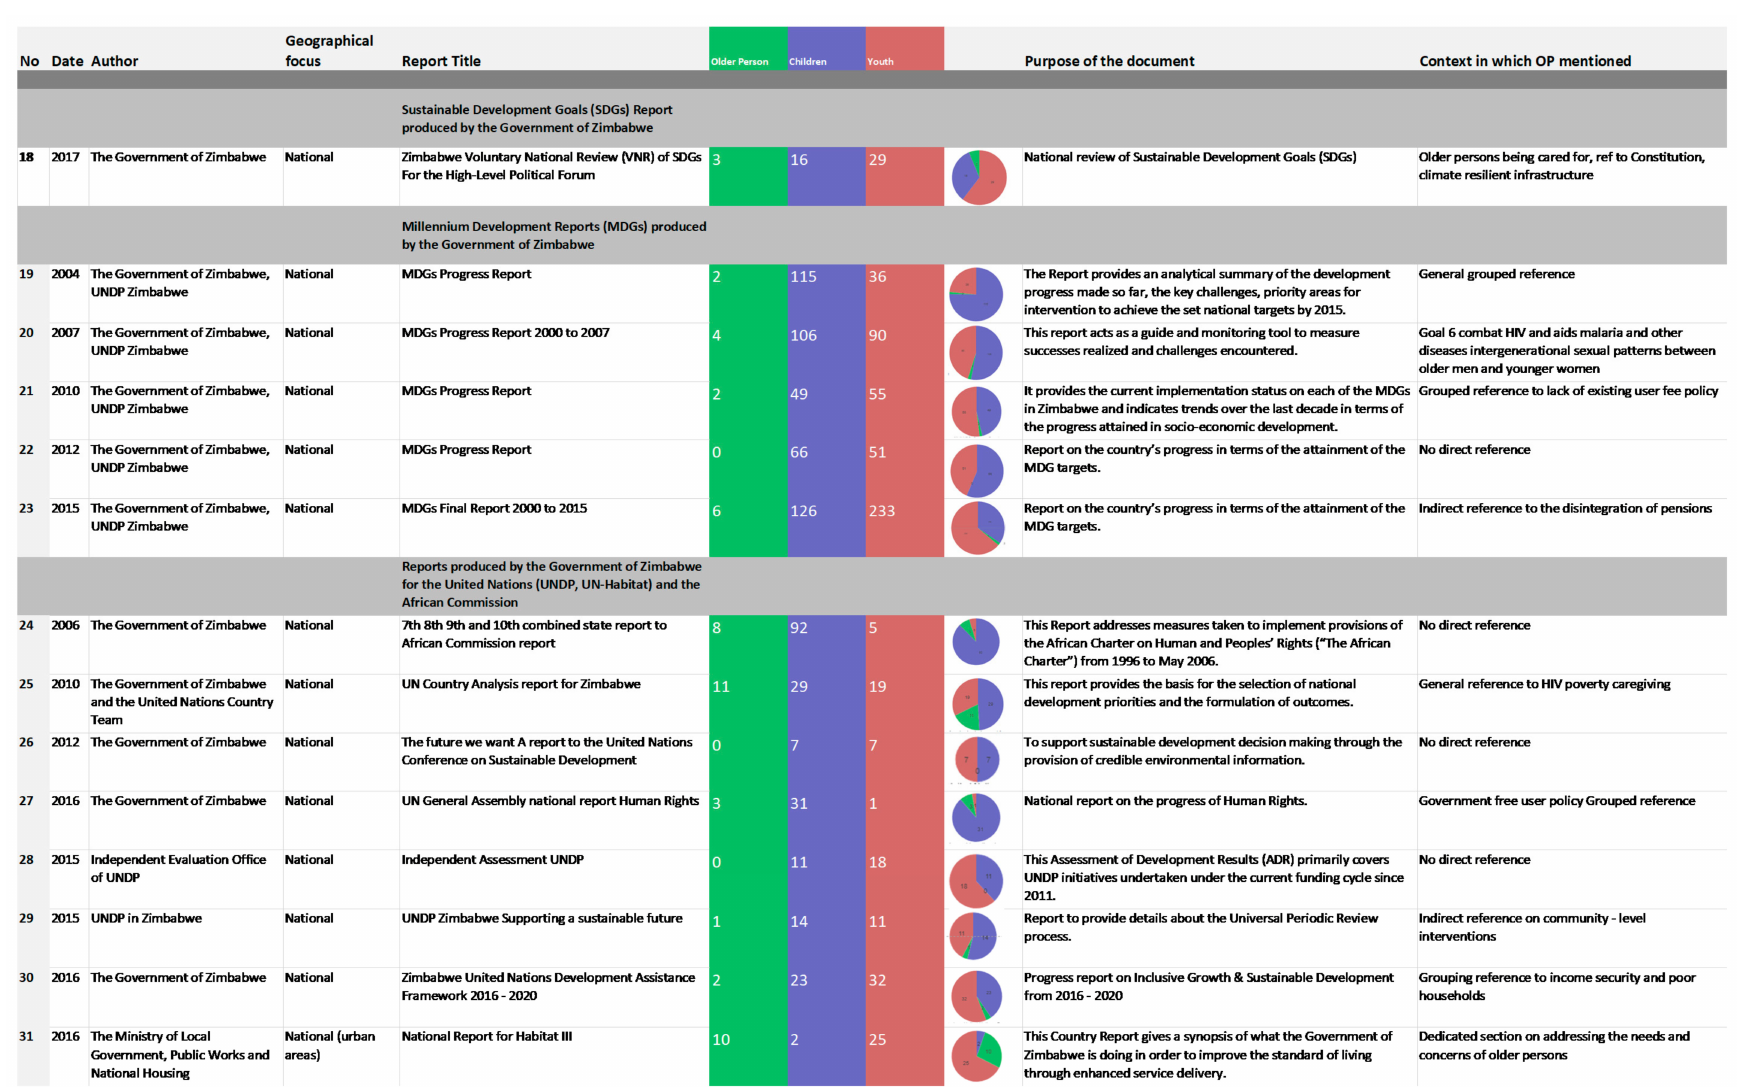
Figure 5. Word frequency and collocation of documents for international